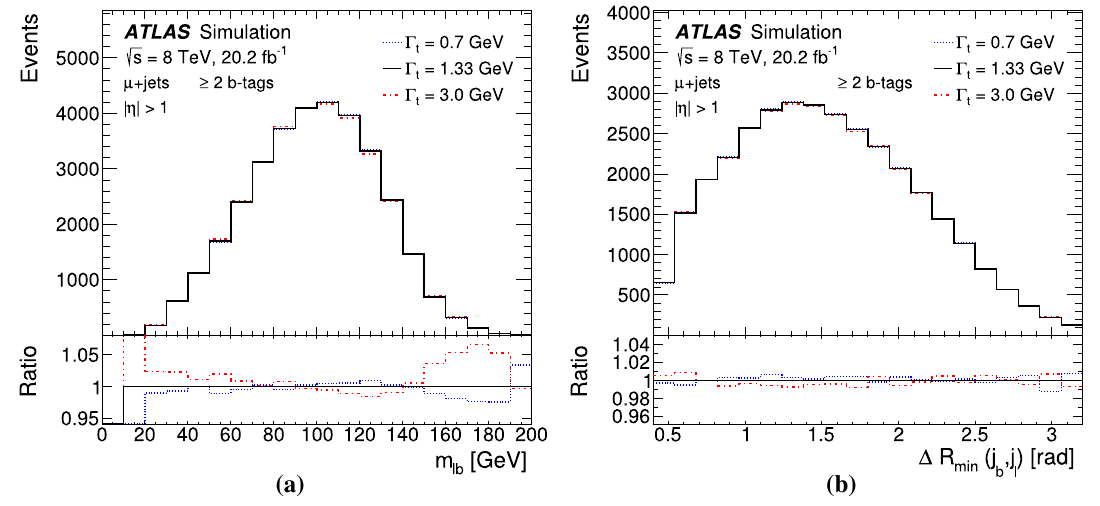
Fig. 4 Templates for a the reconstructed invariant mass of the b -jet of the semileptonically decaying top quark and the corresponding lepton, m (cid:6) b , and b (cid:7) R min ( j b , j l ) , the angular distance between the b -jet j b associated with the hadronic top quark and the closest light jet j l from